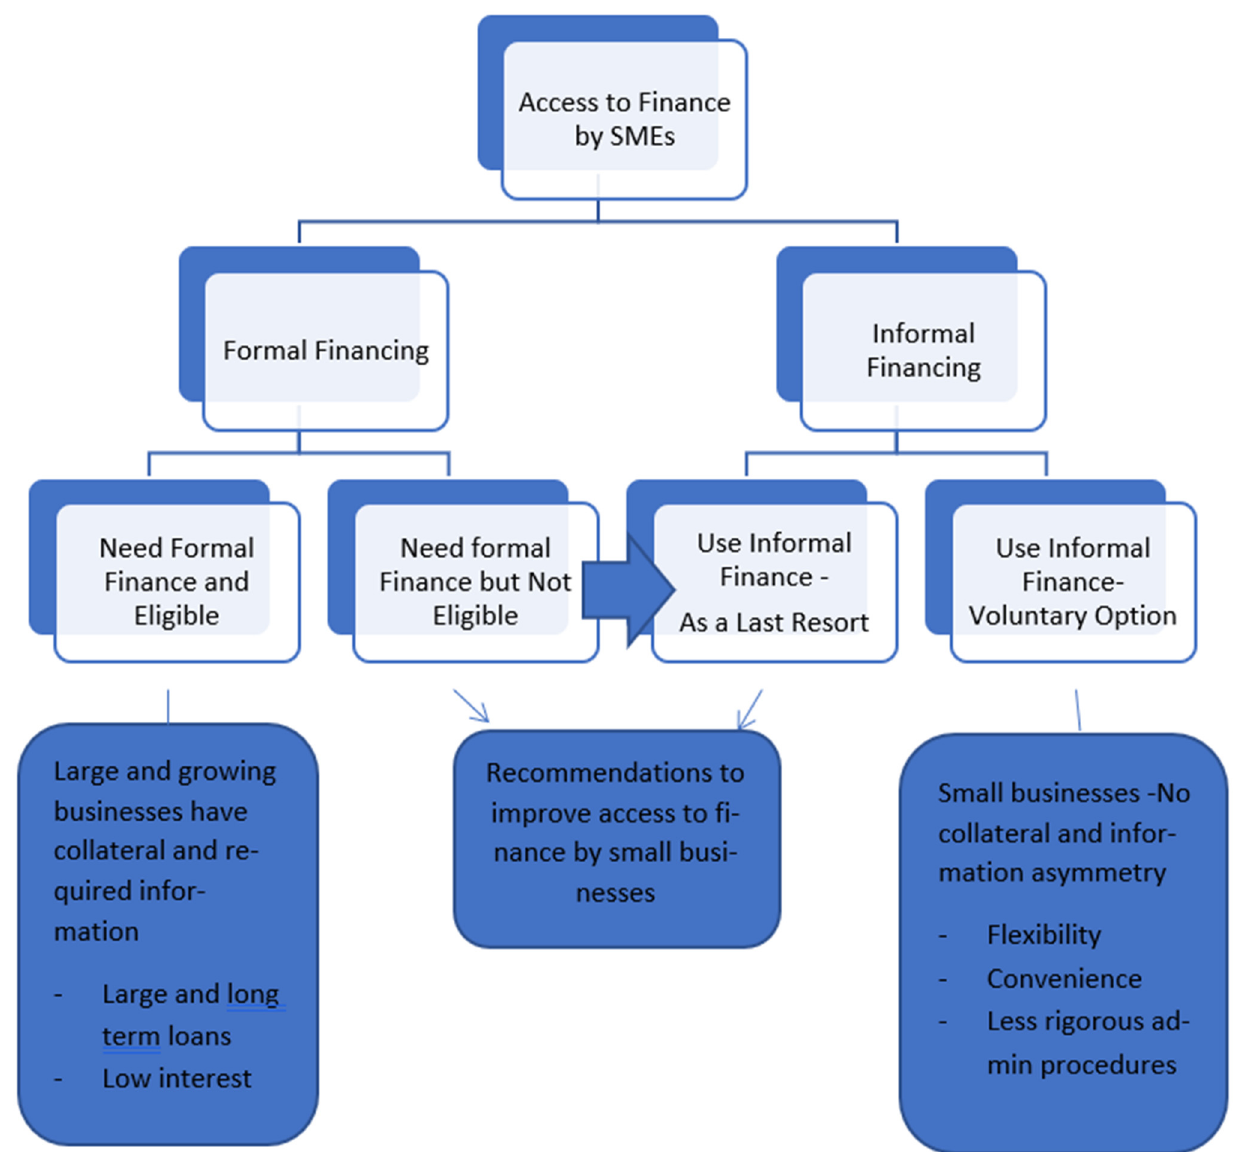
Figure 1. Conceptual framework of access to finance by SMEs. Source: Authors’ own compilation.